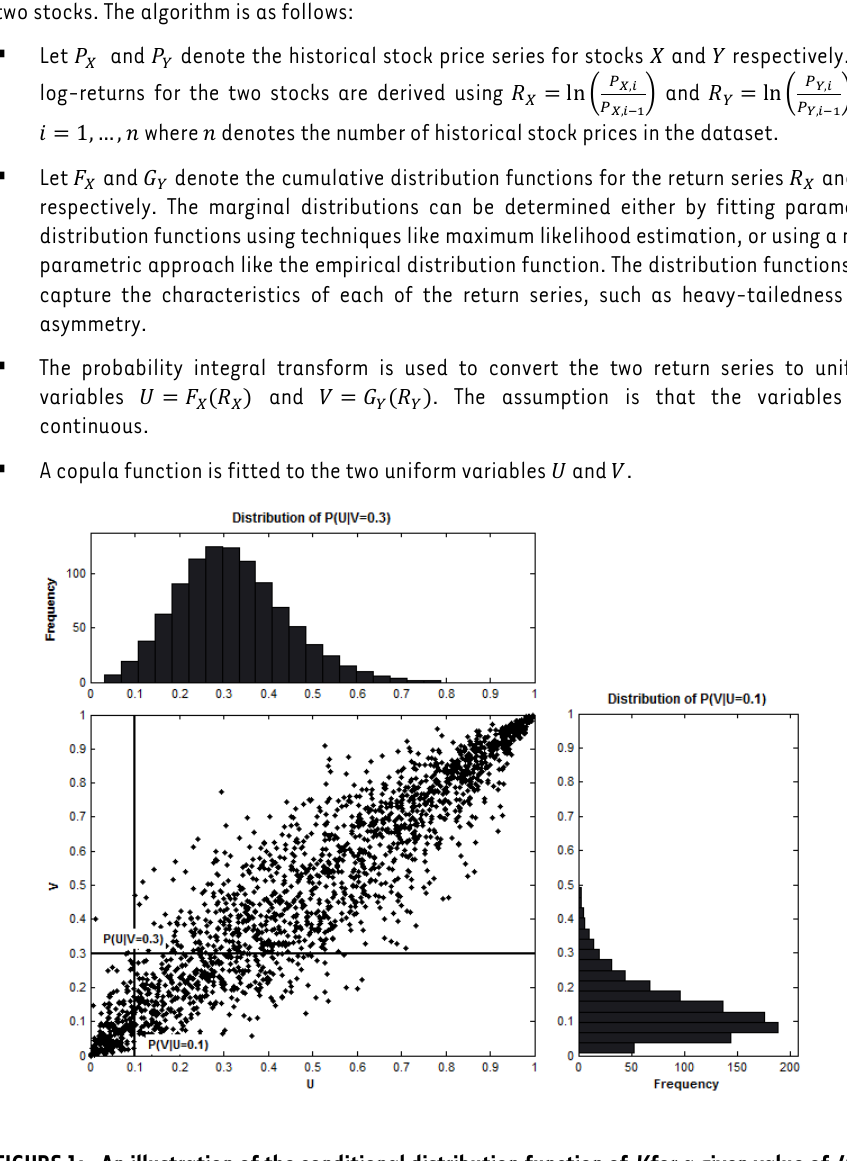
FIGURE 1: An illustration of the conditional distribution function of V for a given value of U and the conditional distribution function of U for a given value of V using the N14 copula dependence